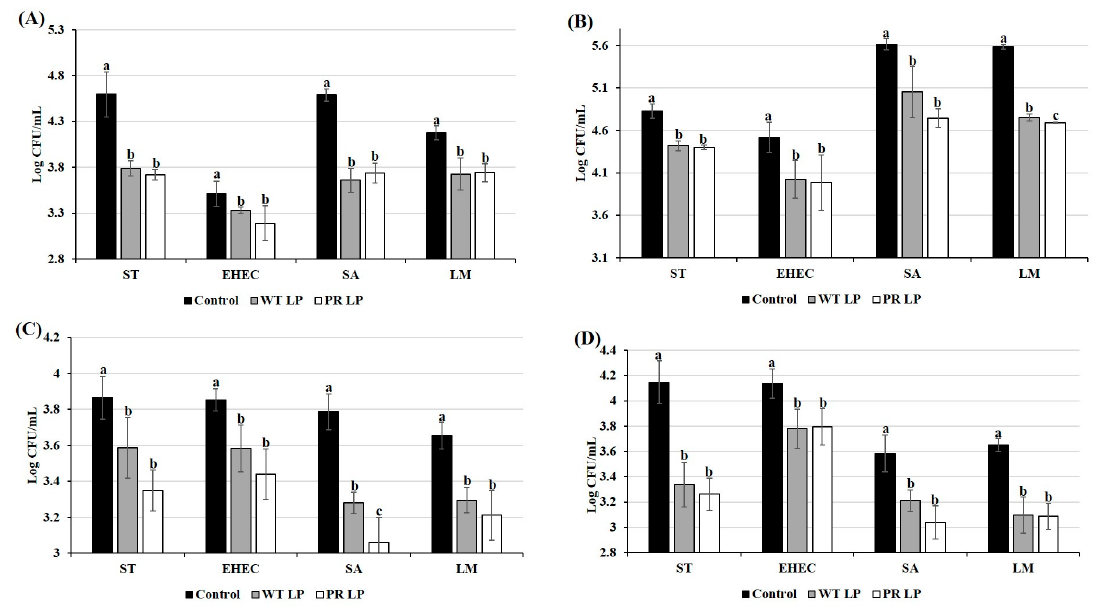
Figure 5. Cell adhesion ( A & C ) and invasion ( B & D ) abilities of S. Typhimurium, EHEC, S. aureus , and L. monocytogenes to INT-407 cells with pre-treatment of wild-type LP and LP +PR strains ( A & B ) and the CFCSs collected from LP and LP +PR ( C & D ). Error bars indicate standard deviation from 6 parallel trials. Different letters (a–c) are significantly different when compared to control at P <